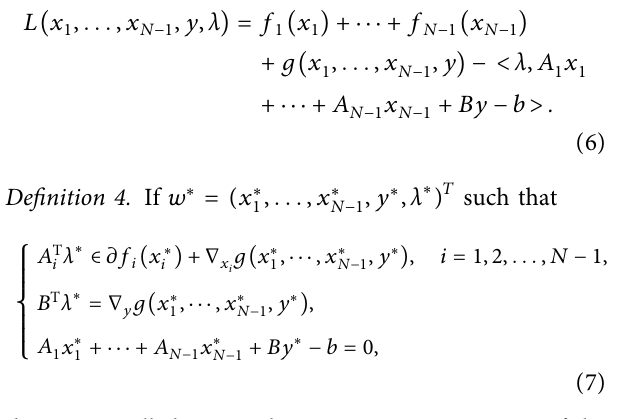
Algorithm 1. LBADMM: start with ( x 0